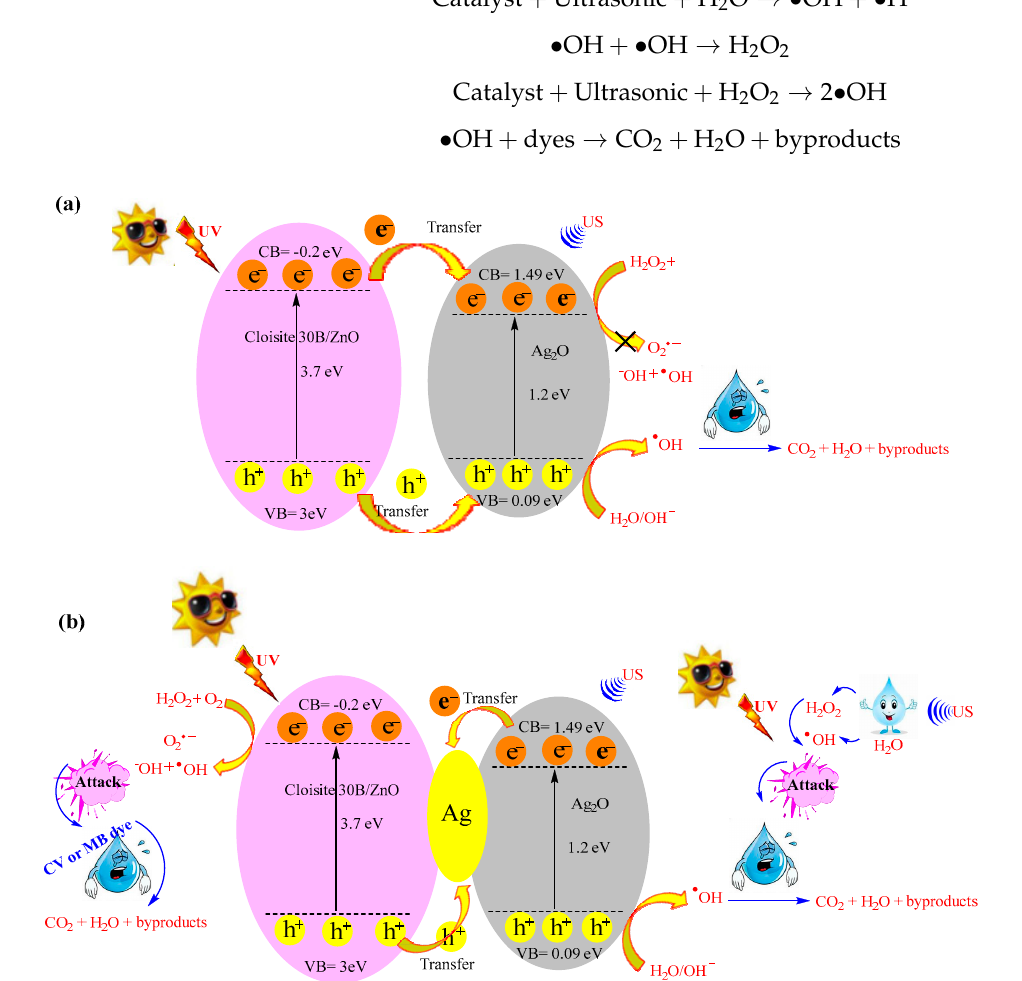
Figure 11. Proposed mechanism for dyes degradation using Cloisite 30B/ZnO/Ag 2 O photocata- lyst, ( a ) the generated electron in the conduction band of Ag 2 O (CB) cannot react with oxygen